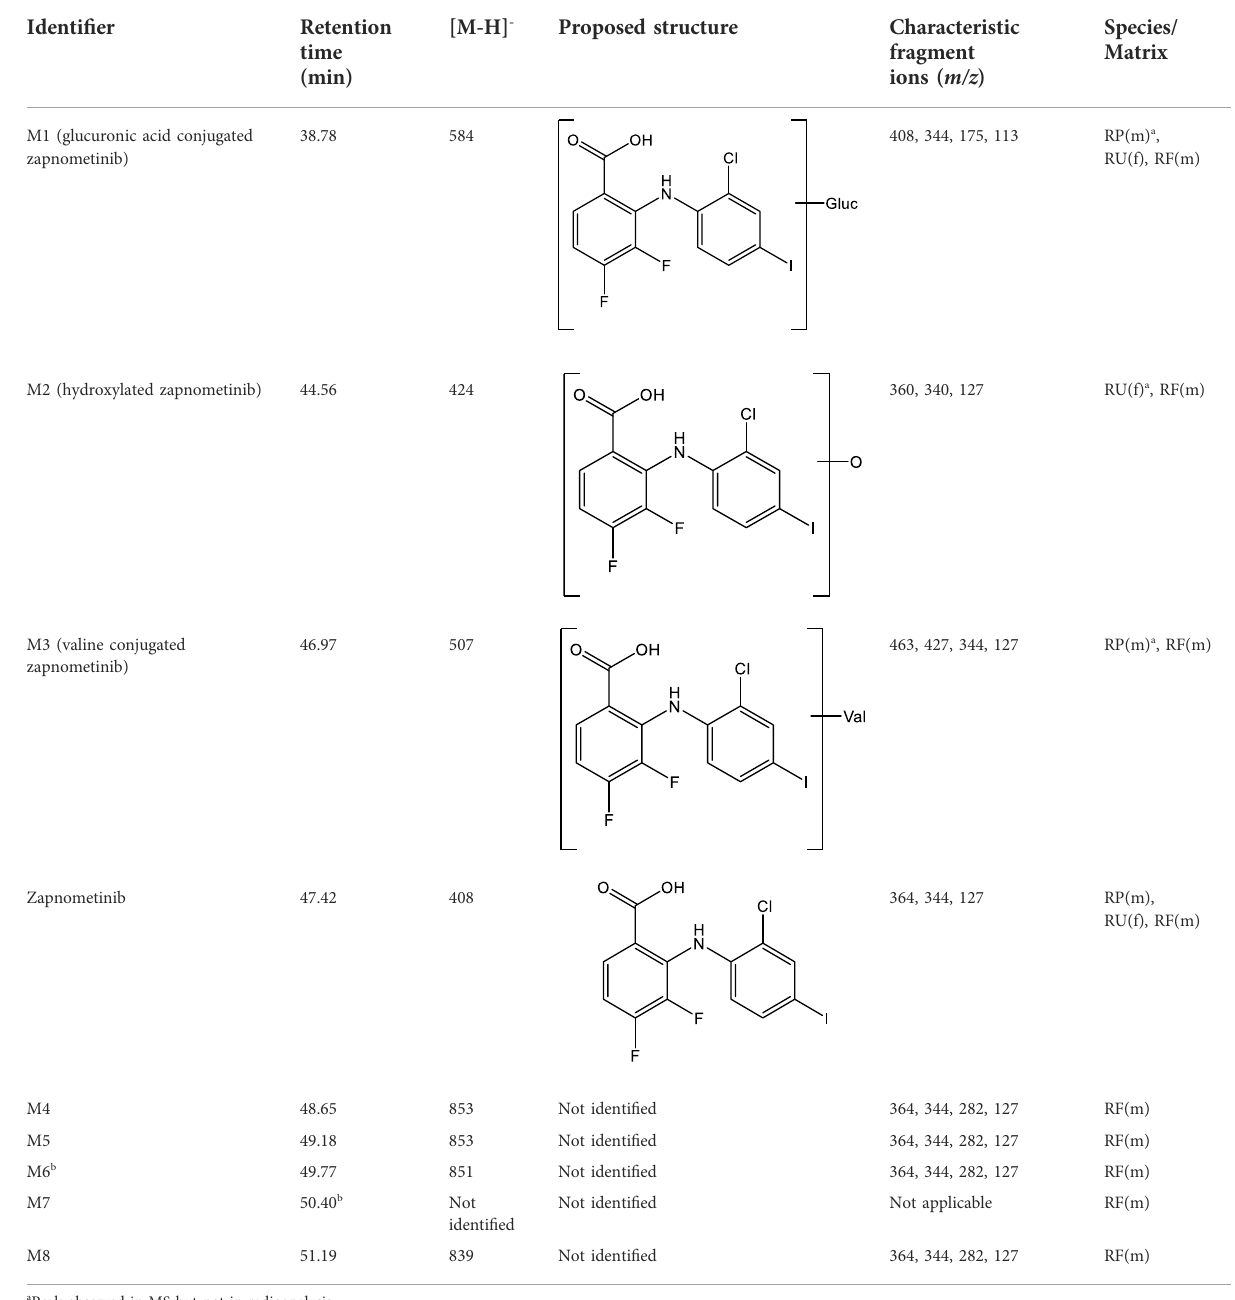
TABLE 3 Summary of deprotonated molecular ions and characteristic fragment ions for [ 14 C] Zapnometinib and identi fi ed